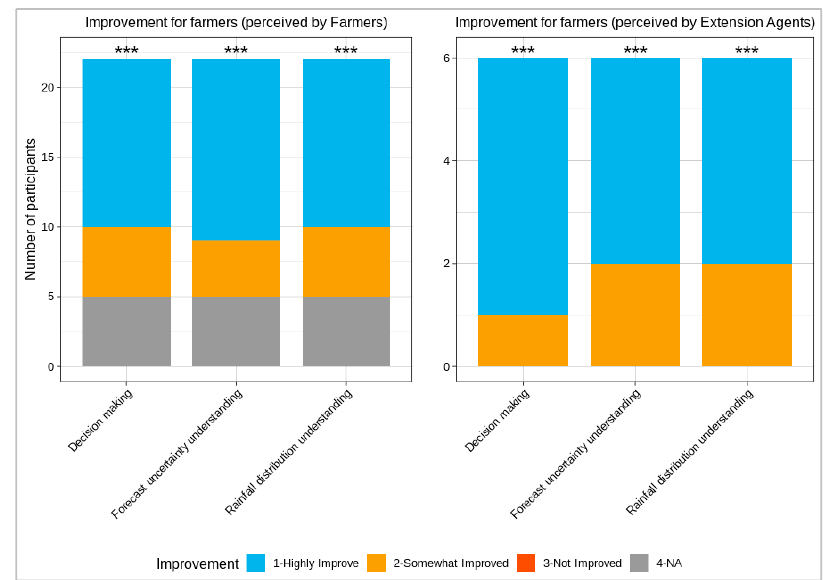
Figure 9. Perception of improvement in farmers’ decision-making, as well as understanding of forecast uncertainty and rainfall distribution, as compared to previous seasons. Farmers were asked if their decisions and understanding improved, while extension agents were asked if they perceived any such improvement. Asterisks (***) indicate the significance of the result for the combined “somewhat and highly improved” category at p < 0.001, based on a binomial distribution test.